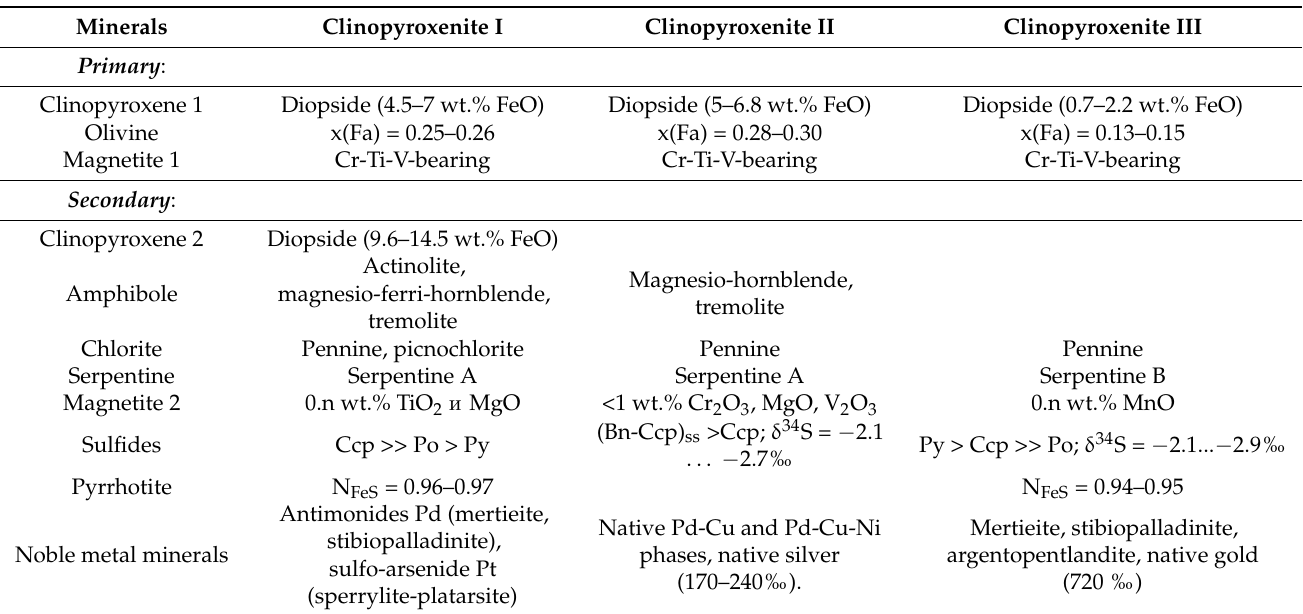
Table 12. Comparative characteristics of primary and secondary minerals of various groups of